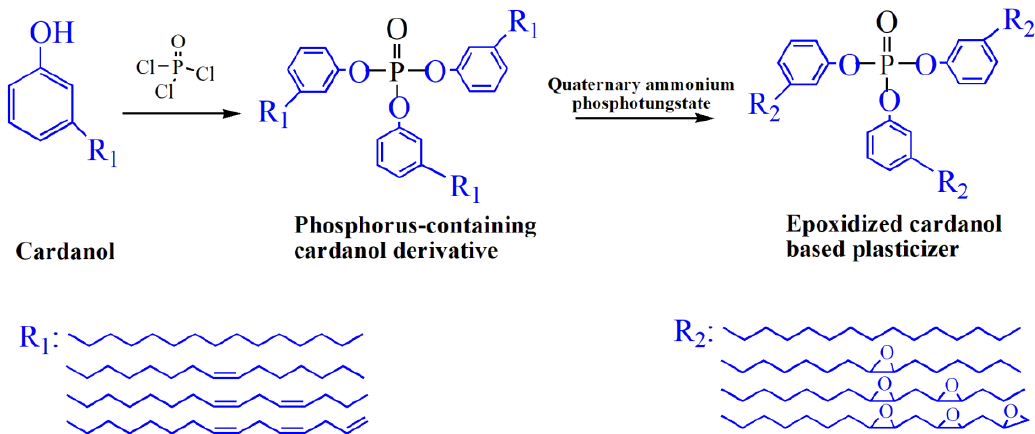
Figure 7. Synthesis routes of epoxidized cardanol based plasticizer (ECP).